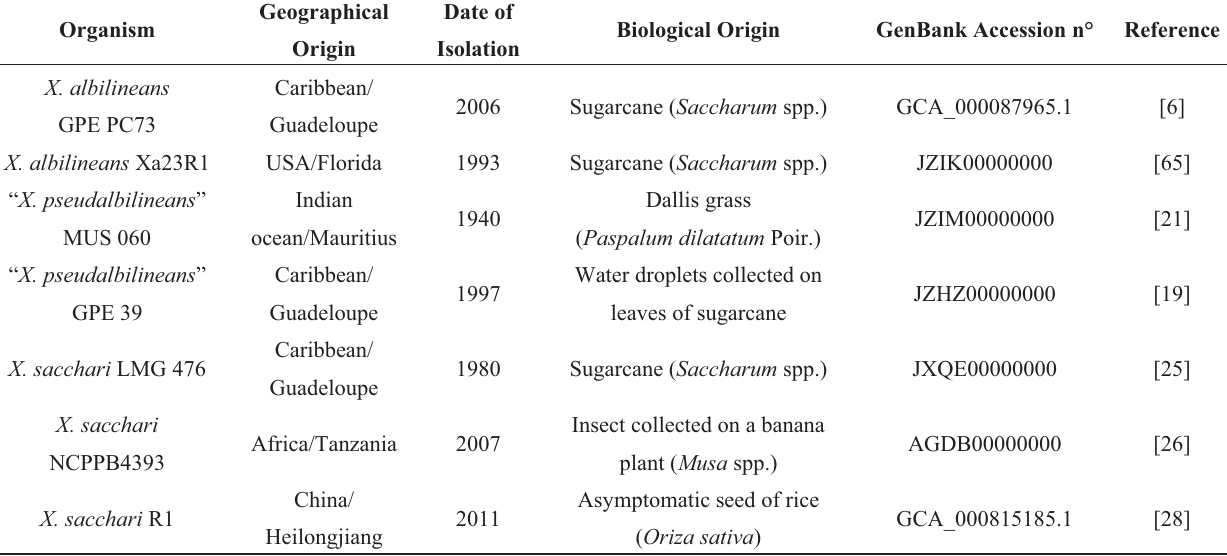
Table 1. Description of Xanthomonas strains